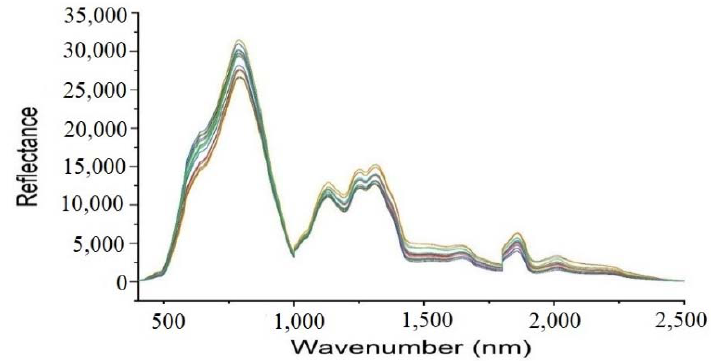
Figure 1. Millet Raw spectra from different geographic regions of China.